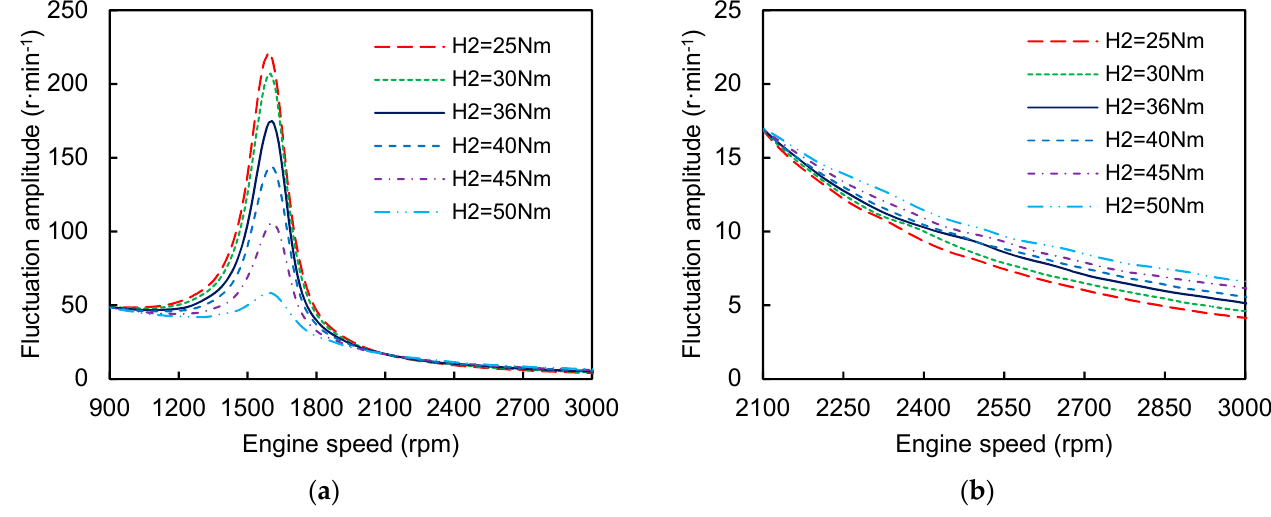
Figure 13. Influence of the second stage hysteresis H 2 on the torsional vibration of driveline.